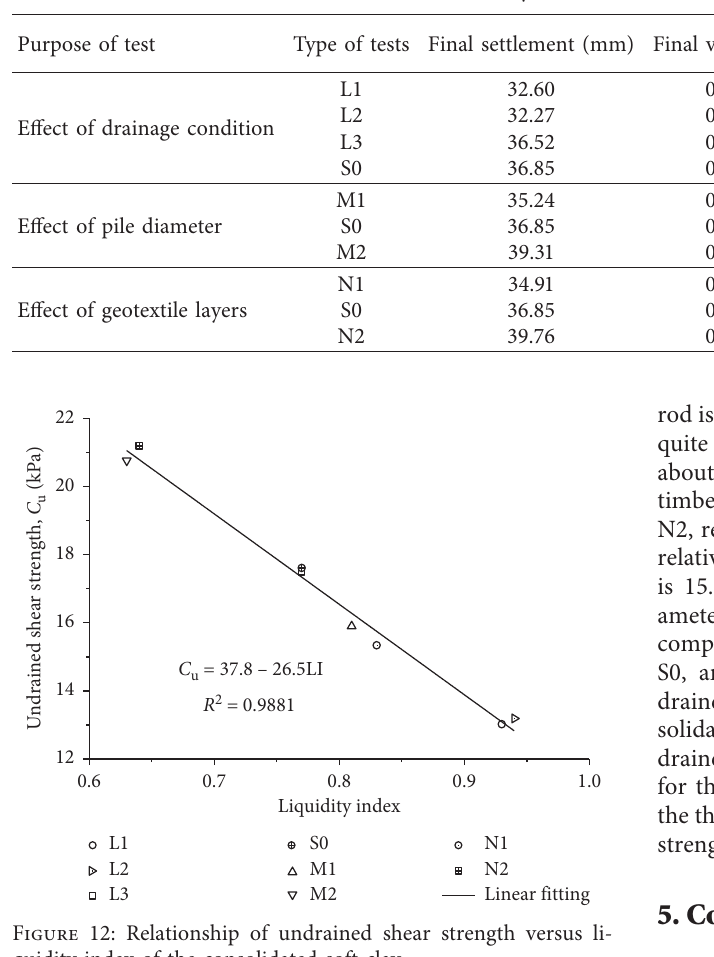
Table 3: Summary of soil-column consolidation test results.